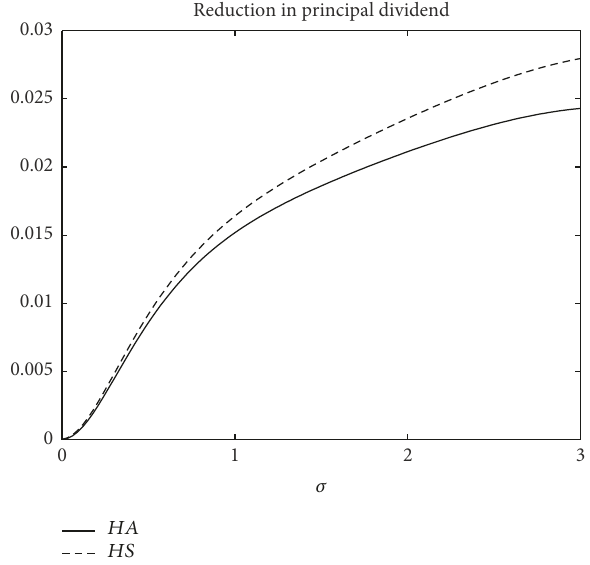
Figure 3: Reduction in the principal’s dividend relative to the full information case for different shock levels 𝜎